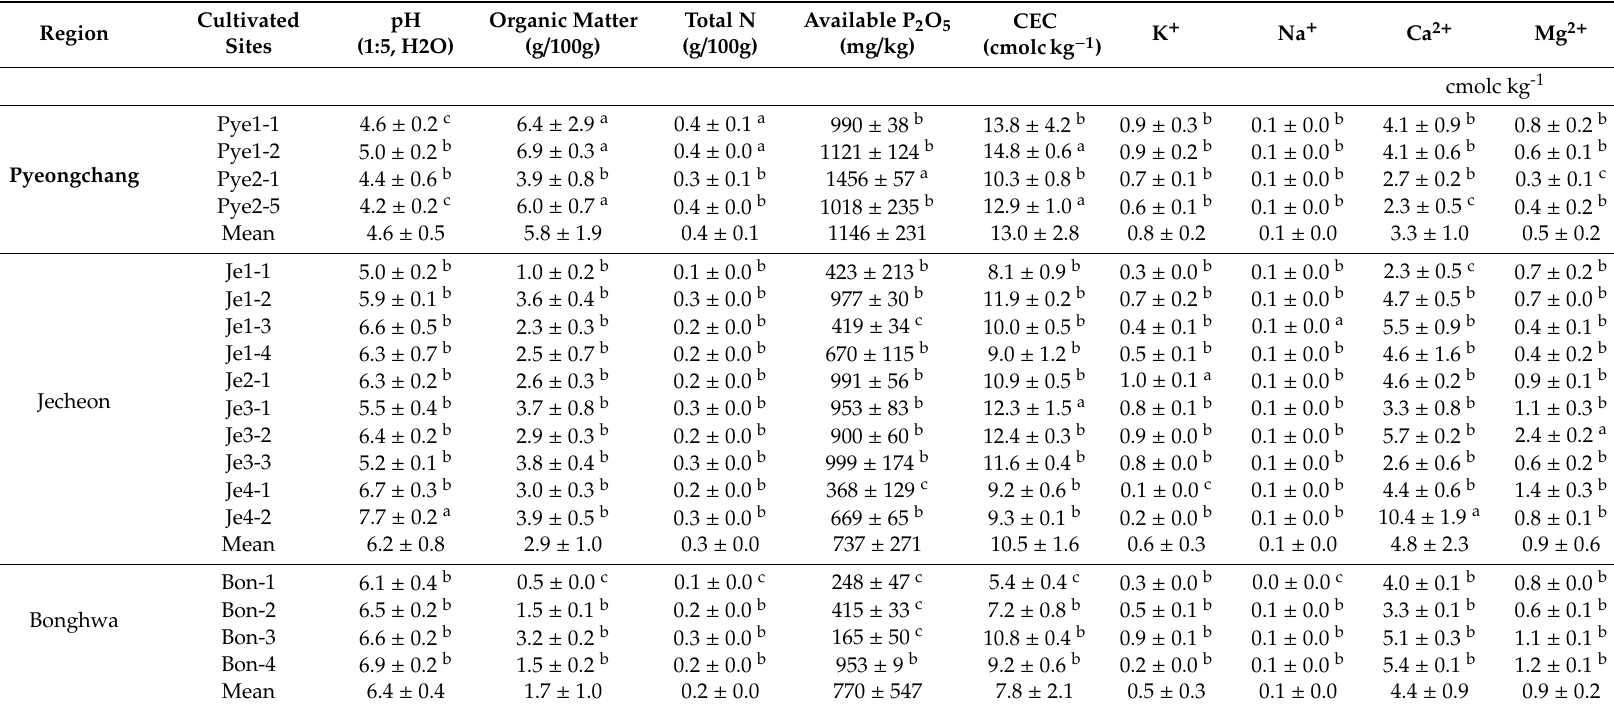
Table 2. Edaphic characteristics of Angelica gigas cultivation sites,